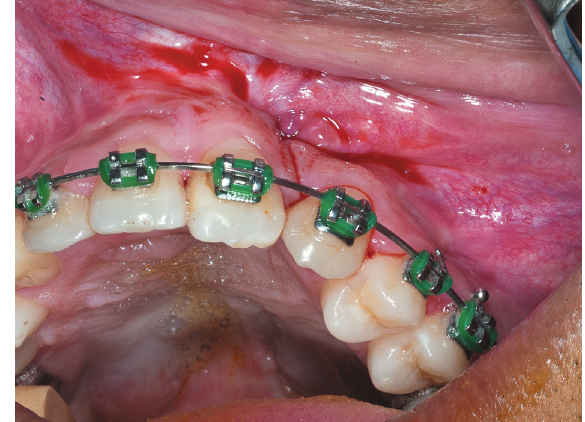
Figure 1- Occlusal view showing the aligment of the maxillary segments